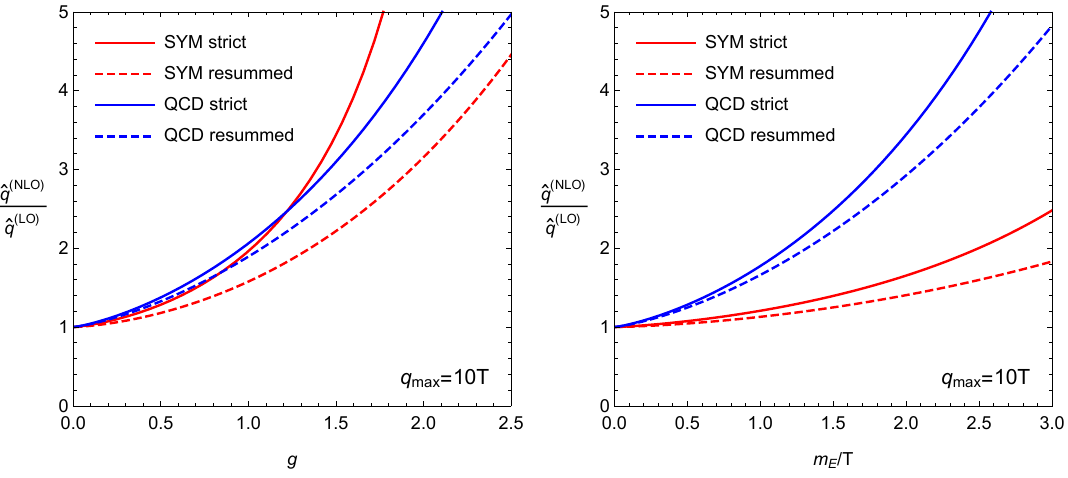
Figure 9 . The NLO/LO ratios for ˆ q in SYM and QCD. For the latter theory N c = N f = 3, for the former N c = 3 on the left, while the r.h.s. is N c -independent. q max = 10 T in both plots. We refer to the text for the precise references to the equations being